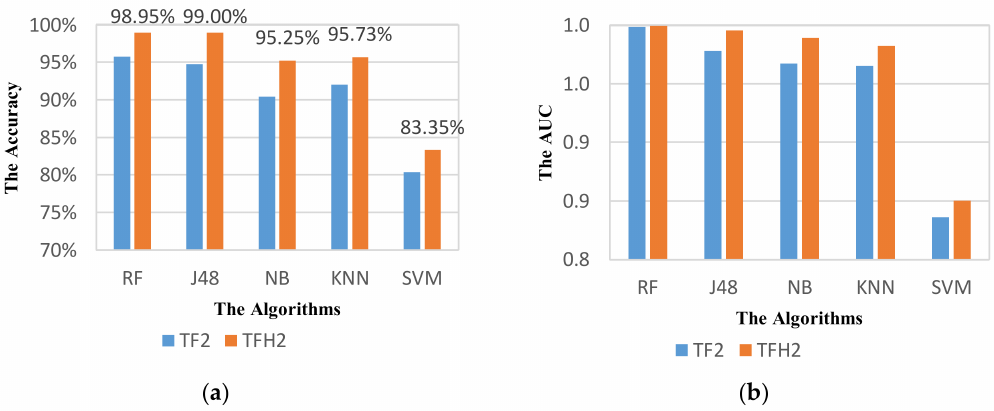
Figure 17. Performance of activity mode detection system with the optimized parameters using different classifiers based on the metric: ( a ) Accuracy; ( b )